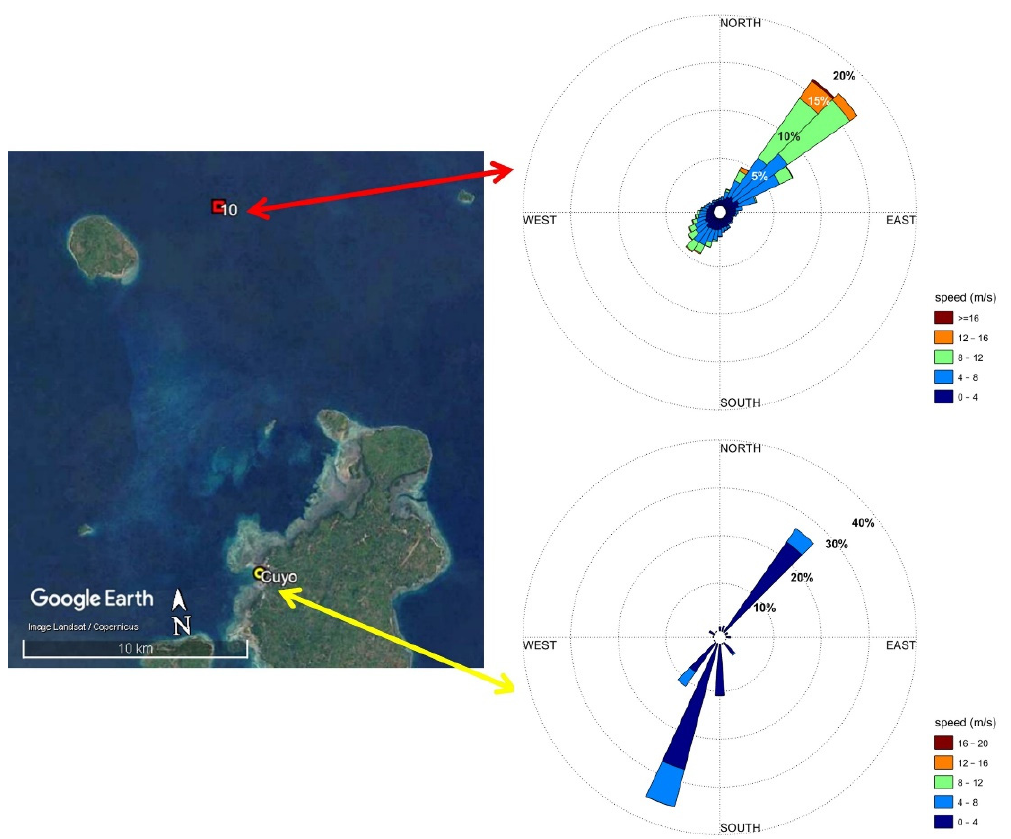
Figure 13. Wind rose diagram of wind velocities using MOV data (upper right panel) and PAGASA data (lower right panel) with the location map of both stations.